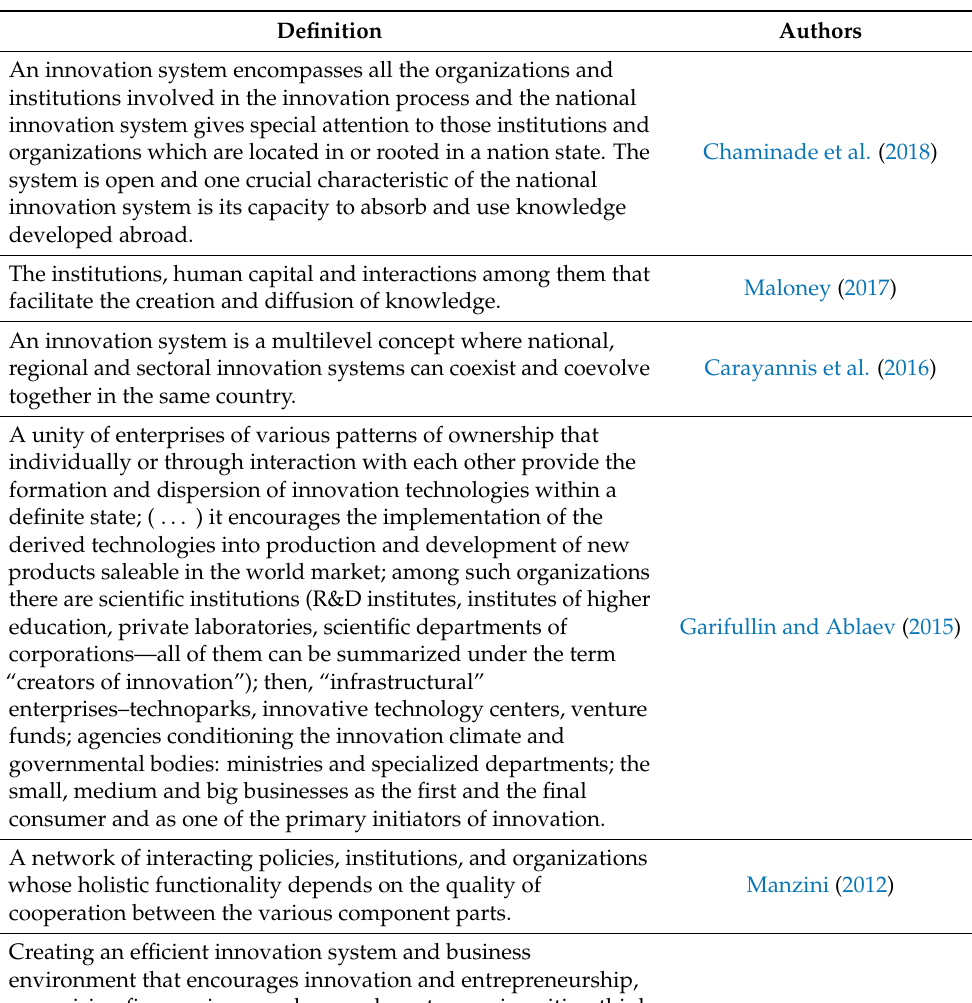
Table 1. Definitions of the national innovation